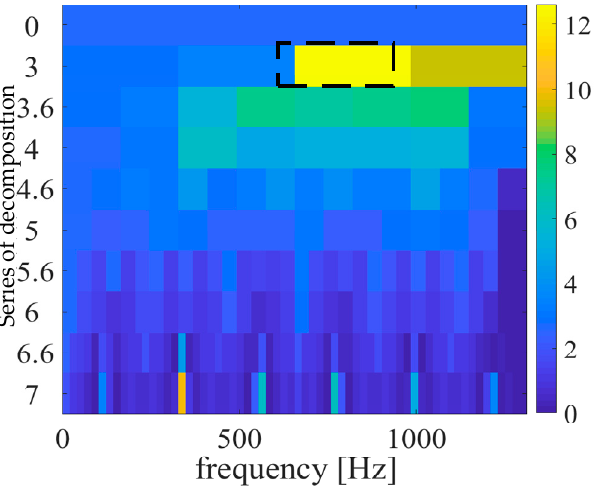
Figure 24. Fast spectral kurtograph. The fast spectral kurtosis diagram is analyzed. The maximum kurtosis value is 12.6, the corresponding center frequency is 815 Hz, and the bandwidth is 328 Hz. The processed fault signals are shown in the Figure 25 below.